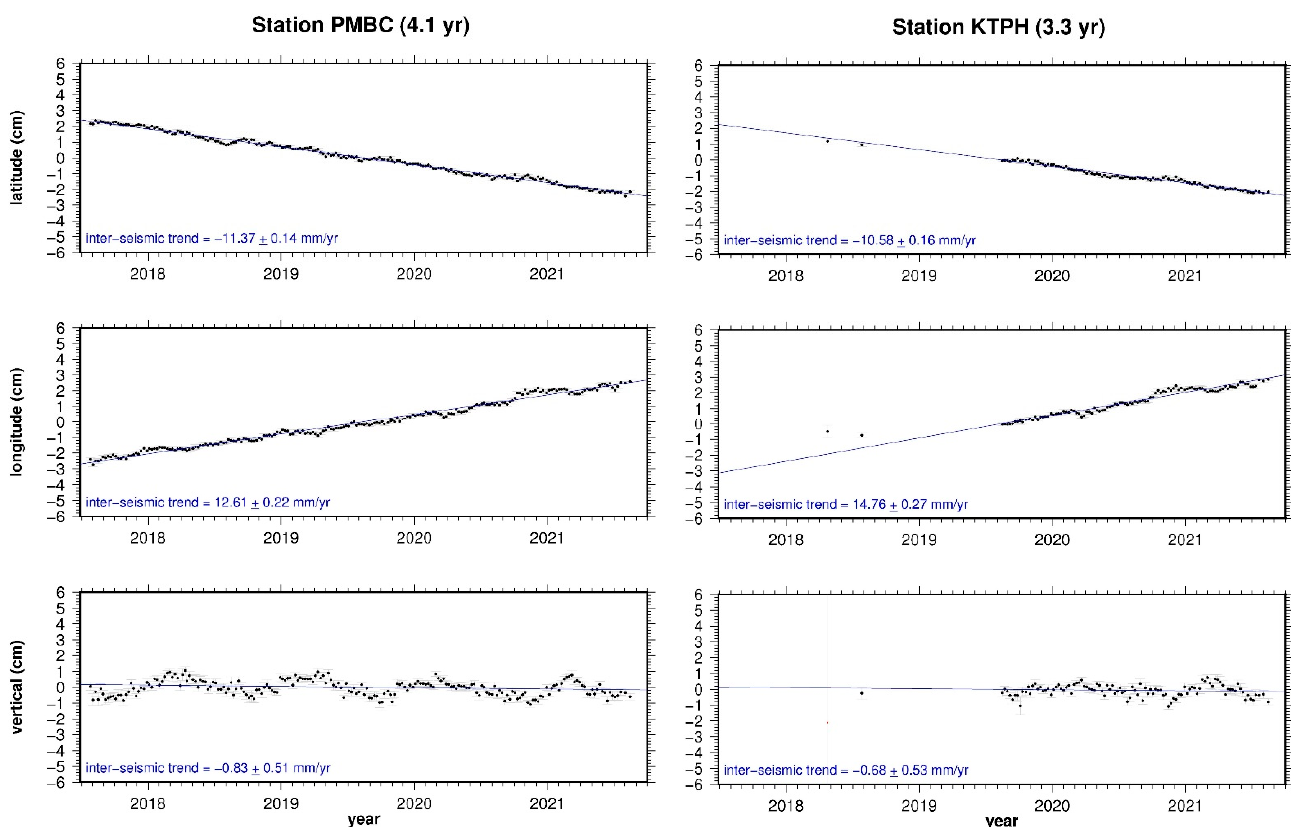
Figure 2. Station position time series (weekly averaged/2017–2021/IGS14) and linear velocity estimates for the stations PMBC and KTPH in Phuket, Thailand. Shown are the velocities in N (latitude), E (longitude) and U (vertical) directions. The time span is 3.3 to 4.1 yr, and position/velocity uncertainties are 1-sigma (68% confidence level) values. The two points for KTPH in 2018 come from two campaign-style observations (using a tripod) prior to installation of the continuous station, whereby the first vertical position solution was marked as an outlier . Table 1. Linear trend velocity estimates (2017–2021) in the IGS14 / ITRF14 global reference frame for the six continuous GNSS stations in Thailand (4), Singapore (1) and eastern Malaysia (1) . Shown are (in the N, E and Up directions) the velocity estimates and standard deviations (1 - sigma/68% confidence level) .